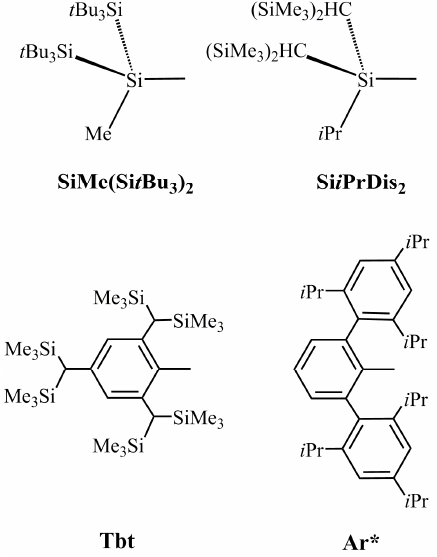
Figure 3. Four bulky groups. For details, see references [66,67].